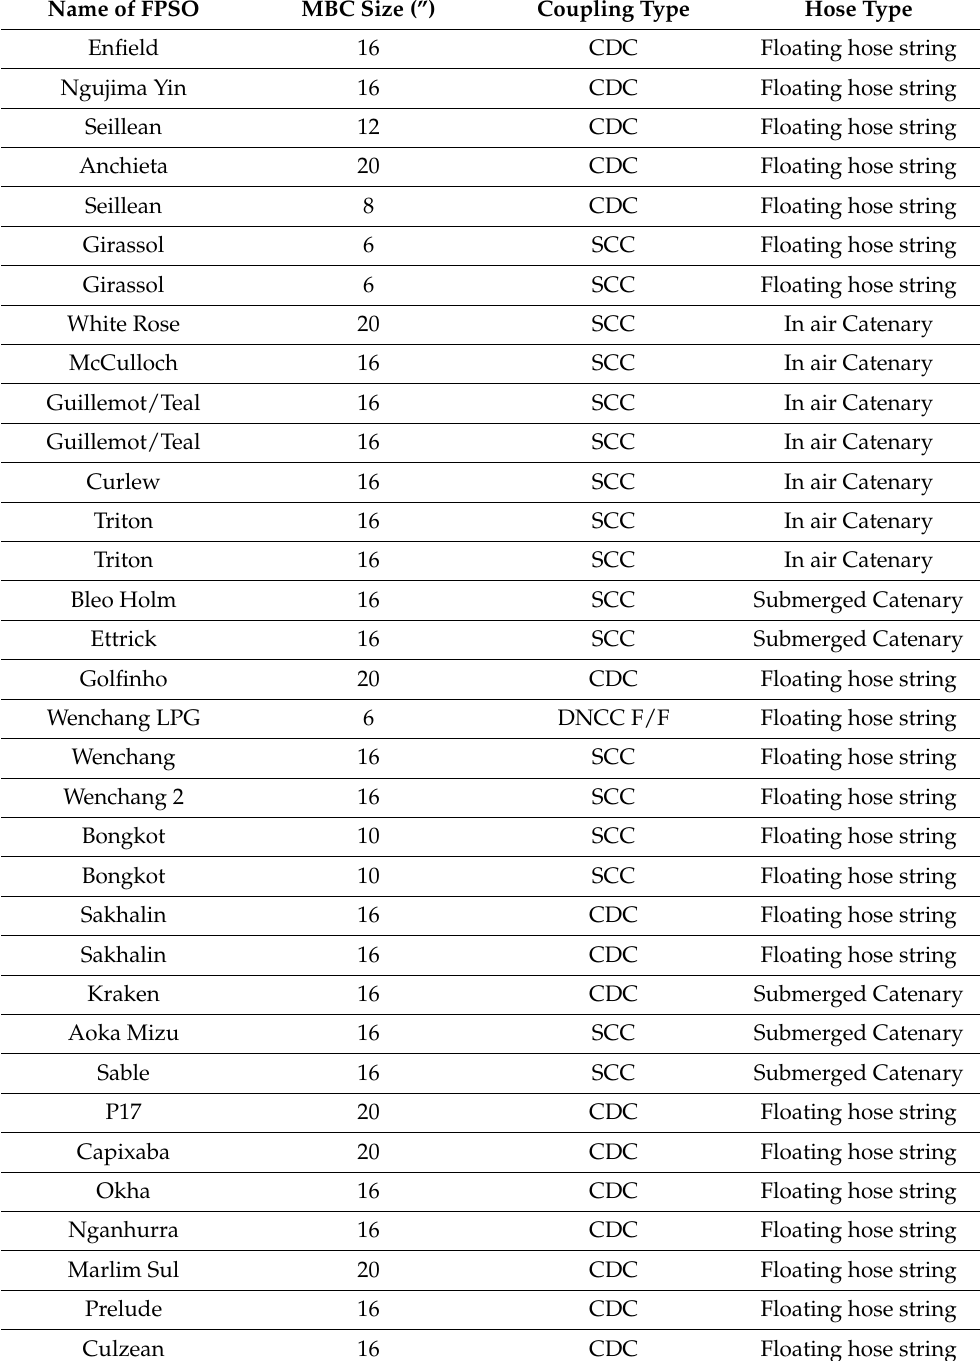
Table 7. FPSO reels with MBCs used (Source: [97]; Shows some combined with a Bow Loading Coupler in floating, submerged, and in air catenary